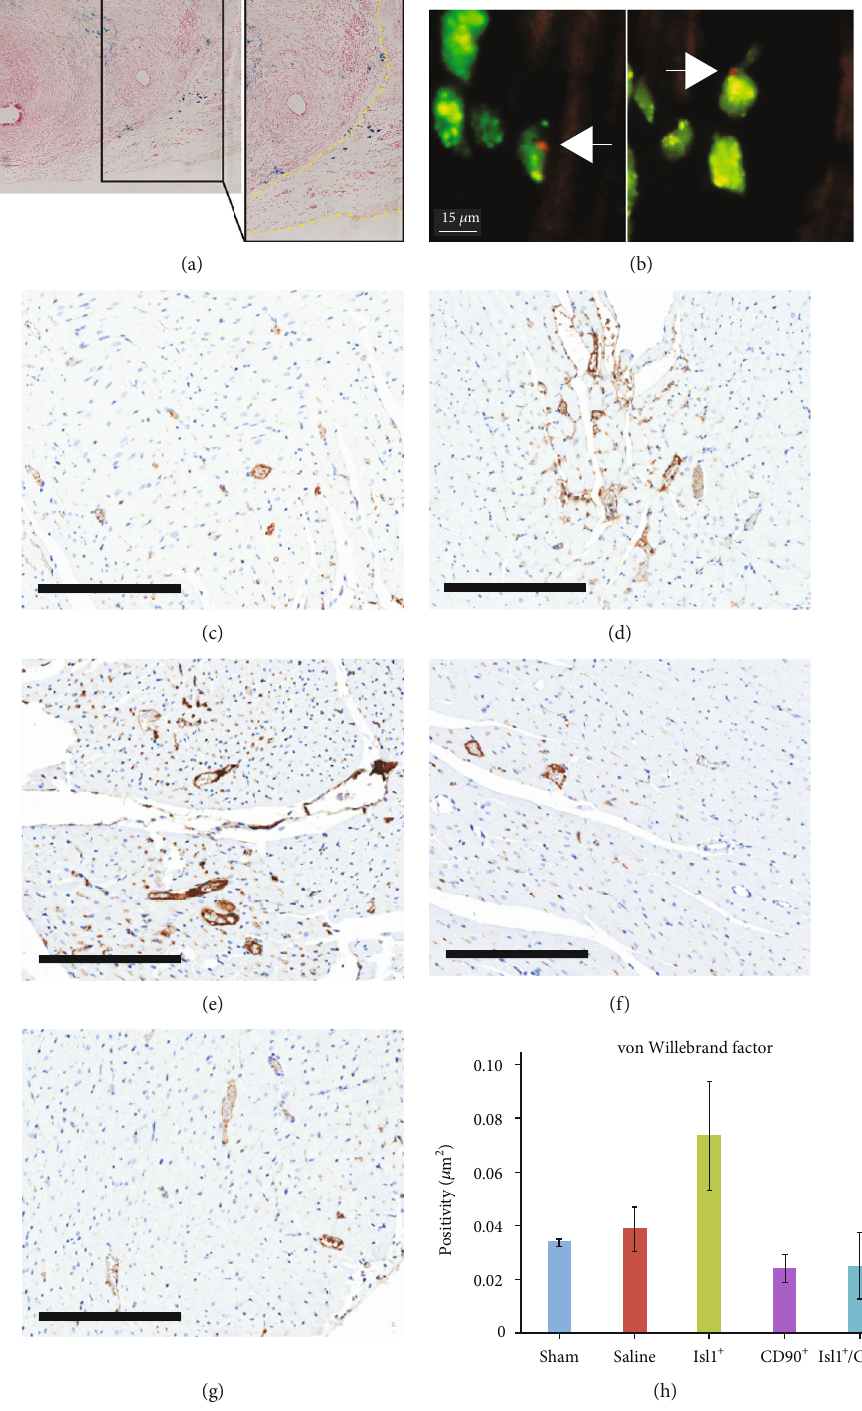
Figure 2: Biodistribution of injected cells using MION labeling and FISH, showing that cell injections do not increase vascular density: (a) Isl-1 + cells retain MION labeling, as shown by Prussian blue staining, 4 weeks following injection with cells in fi ltrating the scar tissue (between yellow dotted lines) suggesting participation in the repair process. (b) Male donor-derived CD90 + cells were detected 4-week post-MI by fl uorescence in situ hybridization (FISH) for the Y chromosome shown in red (arrows). (c) – (g) Representative images from all cohorts of cardiac tissue sections stained for von Willebrand factor. (c) sham; (d) saline; (e) Isl-1 + ; (f) CD90 + ; (g) Isl-1 + /CD90 + ). Scale bar: 200 μ m. (h) Quanti fi cation of all the sections analyzed (saline: 0 : 0388 μ m 2 ± 0 : 008 ; sham: 0 : 0340 μ m 2 ± 0 : 002 ; Isl-1: 0 : 0737 μ m 2 ± 0 : 02 ; CD90 + : 0 : 02 μ m 2 ± 0 : 005 ; Isl-1 + /CD90 + : 0 : 025 μ m 2 ± 0 : 01